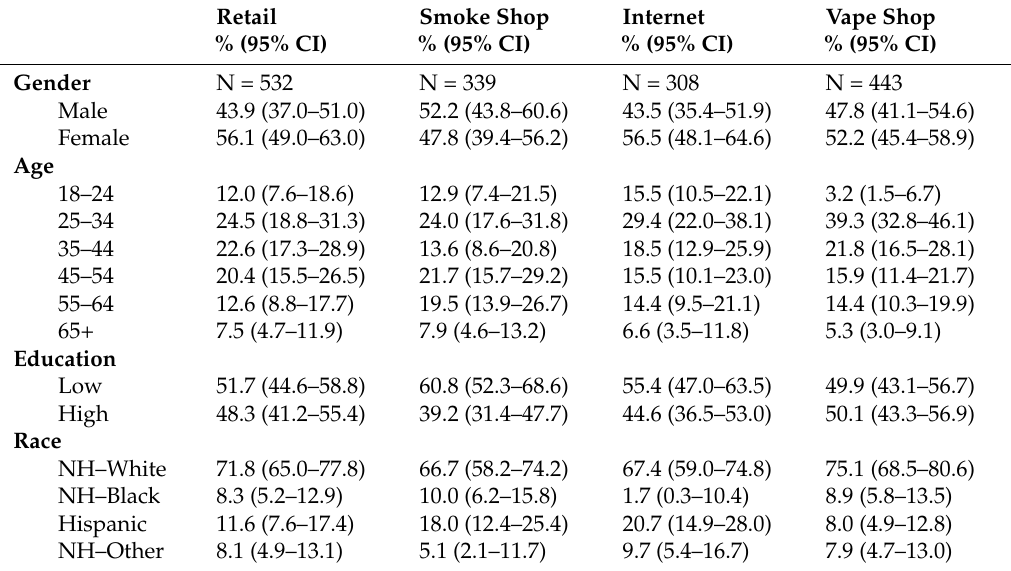
Table 1. Demographics of e-cigarette users by place of purchase (N = 1622, with 2014 and 2016 surveys